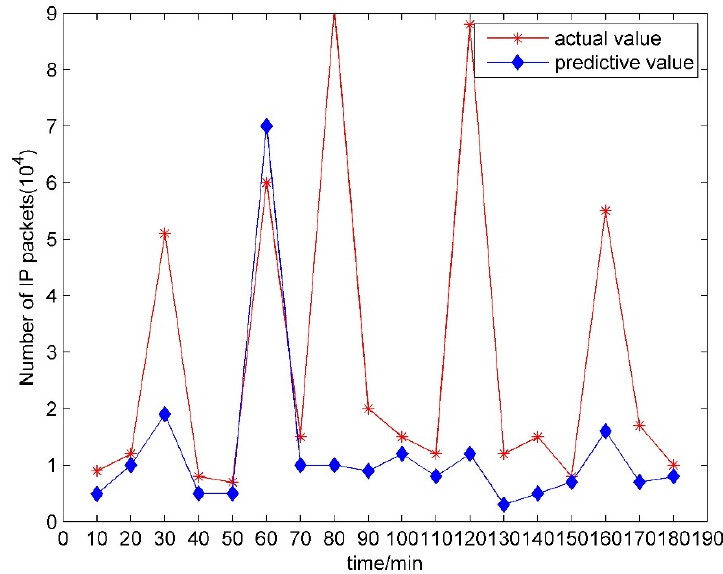
Figure 9. Results of the second DDoS simulated attack experiment.